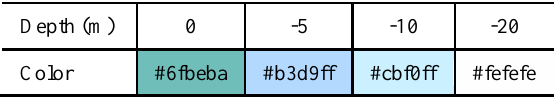
Table 1. Color palette from official hydrographic chart